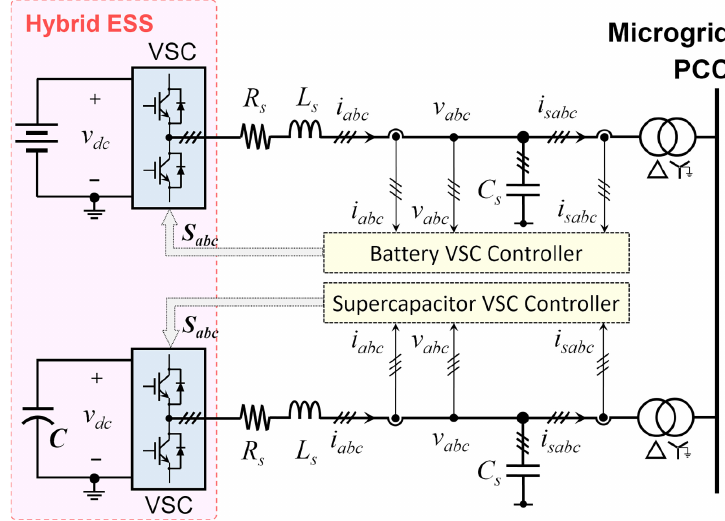
Figure 4. The converter based hybrid ESS power stage